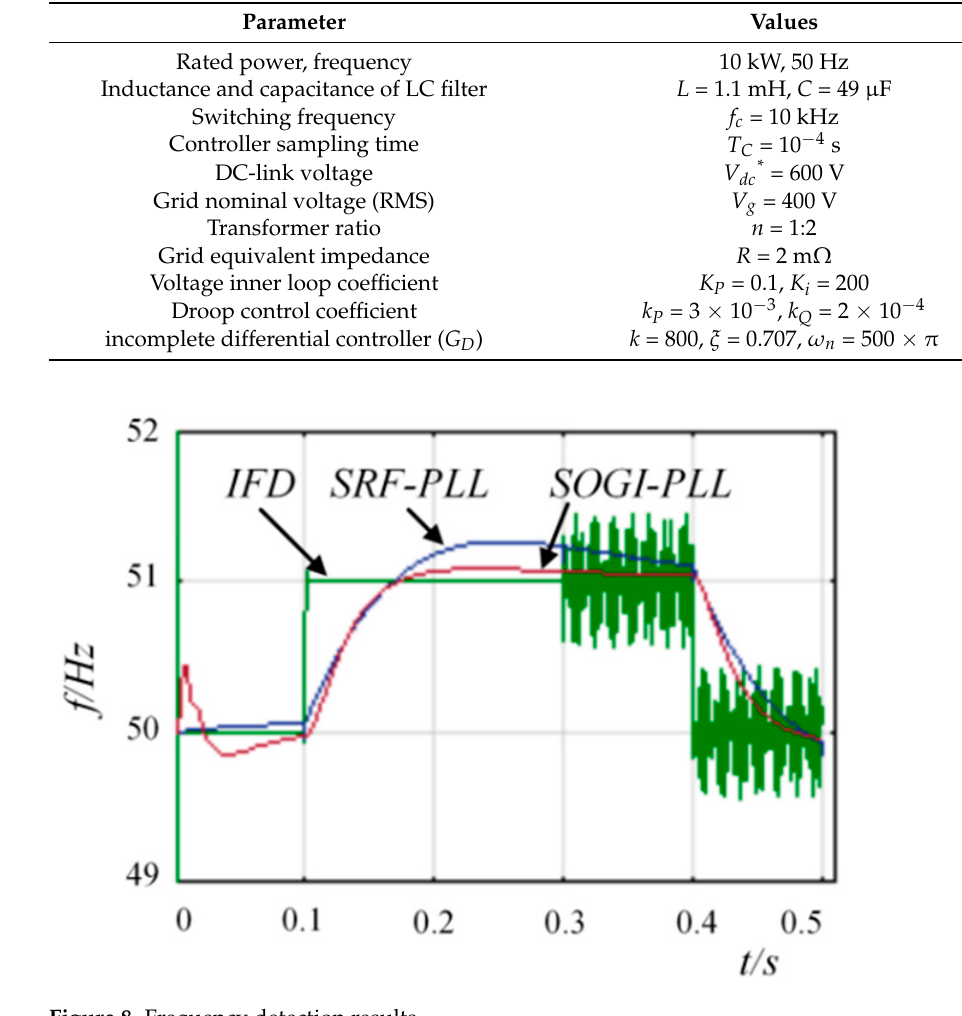
Table 1. Parameters of grid connected inverter system.